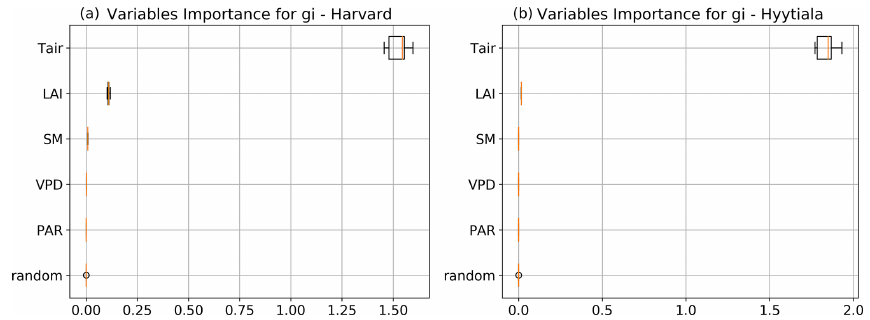
Figure B3. Variables’ importance computed using random forests for the internal conductance (gi) at the Harvard Forest site in 2012 (left) and at the Hyytiälä site in 2017 (right). The considered predictors are air temperature ( T air ), leaf area index (LAI), soil moisture (SM), vapour pressure deficit (VPD), and photosynthetically active radiation (PAR). A random predictor is added to prevent over-fitting.